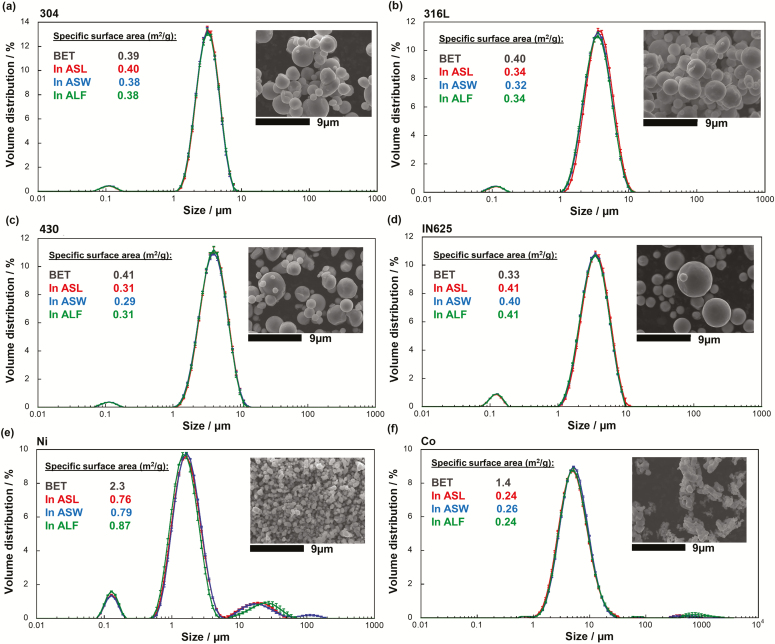
Particle size distribution (by volume) and calculated specific surface area (m2 g−1) of the alloy and metal powders (a: 304, b: 316L, c: 430, d: IN625, e: Ni and f: Co) in ASL (pH 6.75), ASW (pH 6.5), and ALF (pH 4.5) measured by means of static light scattering, and data on specific surface area (m2 g−1) at dry conditions based on nitrogen adsorption (BET). Average values of three measurements are shown with a standard deviation less than 10% (shown as error bars) in all cases for the size distribution values. The inset SEM images show the corresponding morphology of the particles at similar magnification for all powders (data partially based on Wang et al., 2019 and included for comparison).